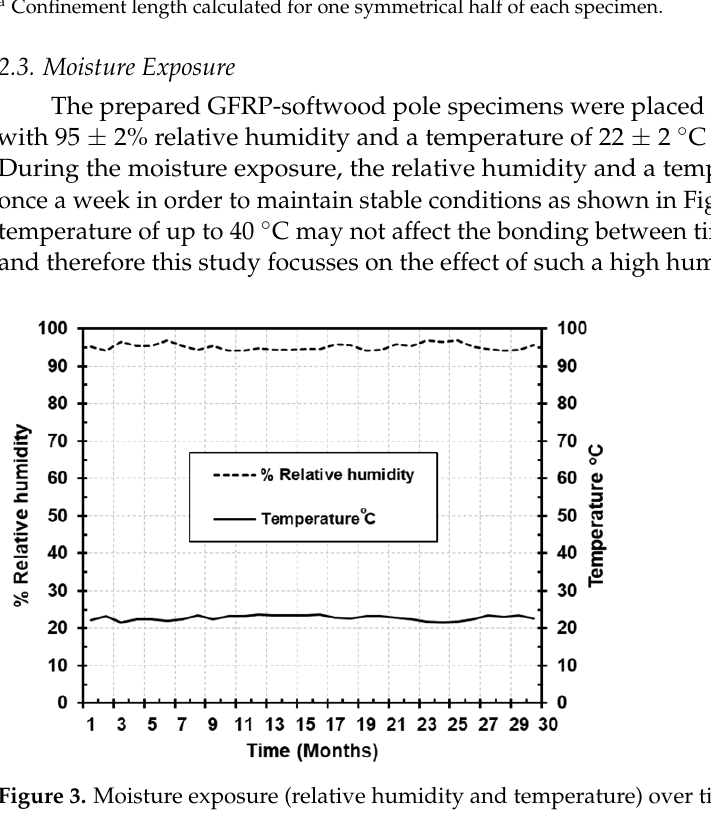
Figure 3. Moisture exposure (relative humidity and temperature) over time. According to the climate statistics of Australia [57], the maximum measured relative humidity is around 80% in the Victoria region and this value is usually reached in one month every year. By subjecting the GFRP-softwood pole specimens to higher relative humidity conditions of about 95% for the period of 30 months, it would be assumed to represent 30 years of exposure of high